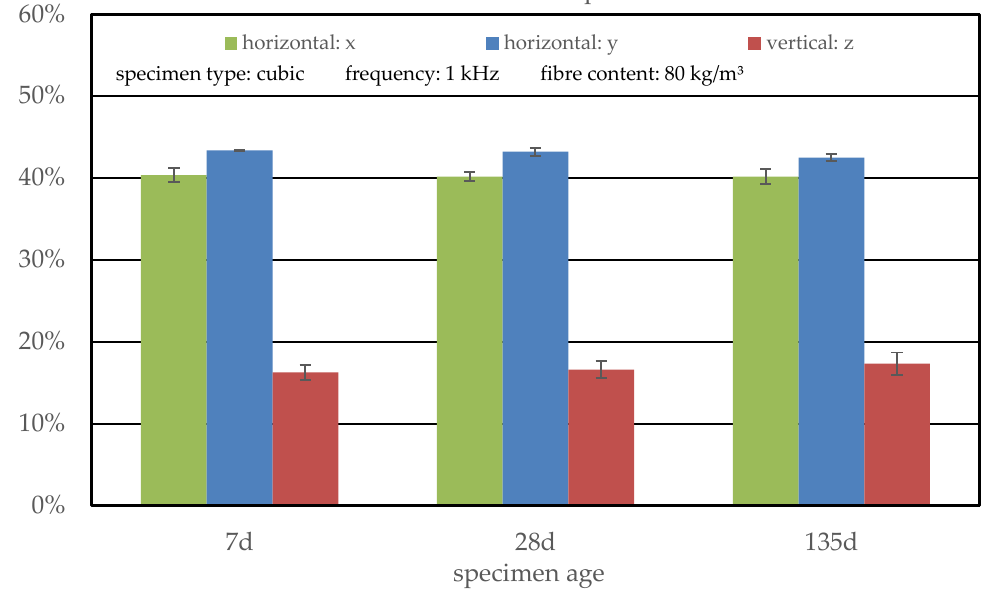
Figure 9. Calculated fibre orientation of the cubic specimens with a fibre content of 80 kg/m³, based on the electrical resistivity measurements on specimens with different concrete ages at a frequency of the alternating current of 1 kHz.